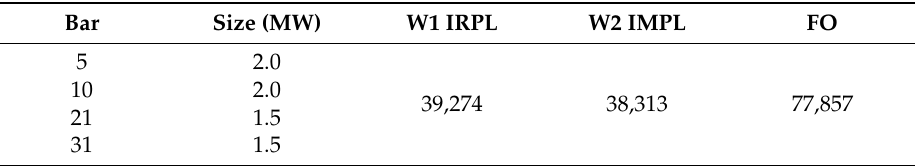
Table 5. Best result using Variable Search Environment Descending